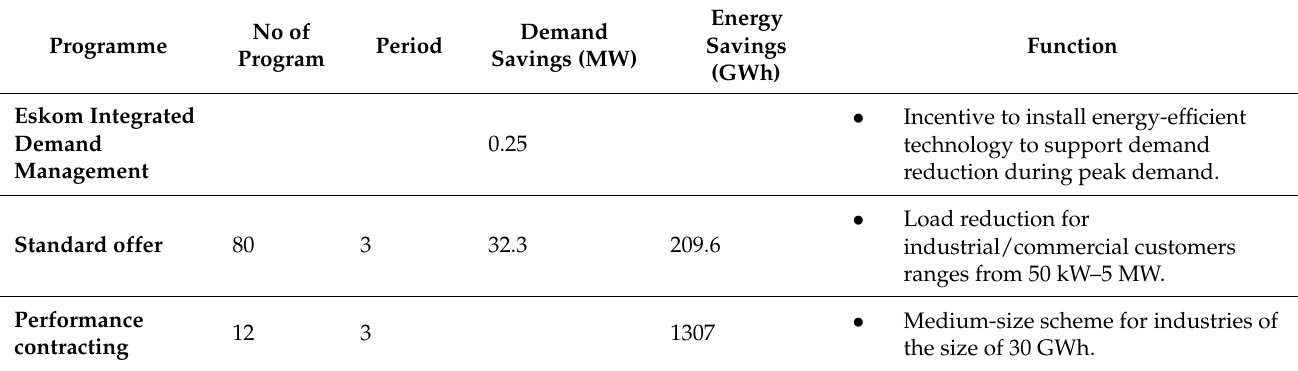
Table 8. EE programmes in South Africa